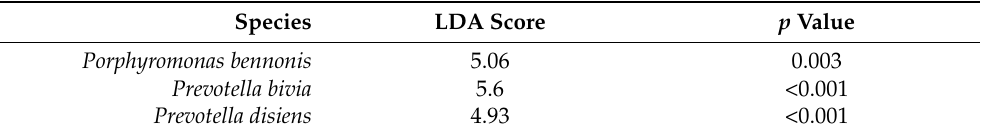
Table 3. Biomarkers at the bacterial species level. The linear discriminative analysis (LDA) effect size (LEfSe) test shows that the bacterial species were significantly different in the comparison of the samples from the unexplained infertility group with those of the explained infertility group. The relative abundances of the bacterial species are shown in Figure 2. Positive values of LDA scores (log 10) are indicative of enriched taxa in a given